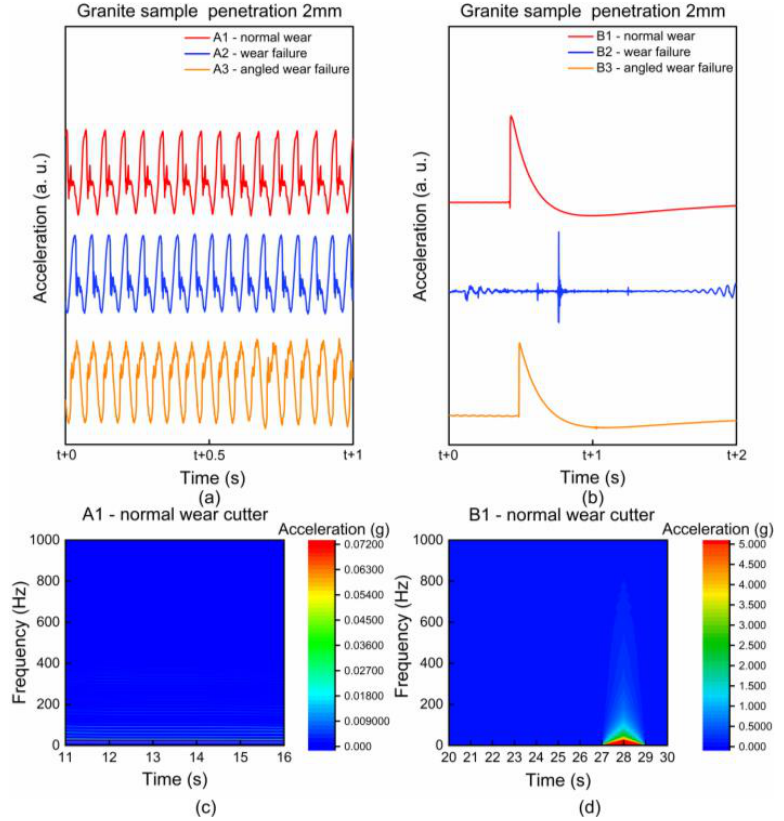
Figure 5. Granite sample, penetration 2 mm, comparison of periodic and non-periodic regions of different cutters in the time domain: ( a ) periodic waveform in area A1, A2, A3; ( b ) wave characteristics of areas B1, B2, B3; ( c ) A1 periodic waveform area, 0~1000 Hz, frequency-domain characteristics; ( d ) B1 deep- and long-crack area, 0~1000 Hz, frequency-domain characteristics.